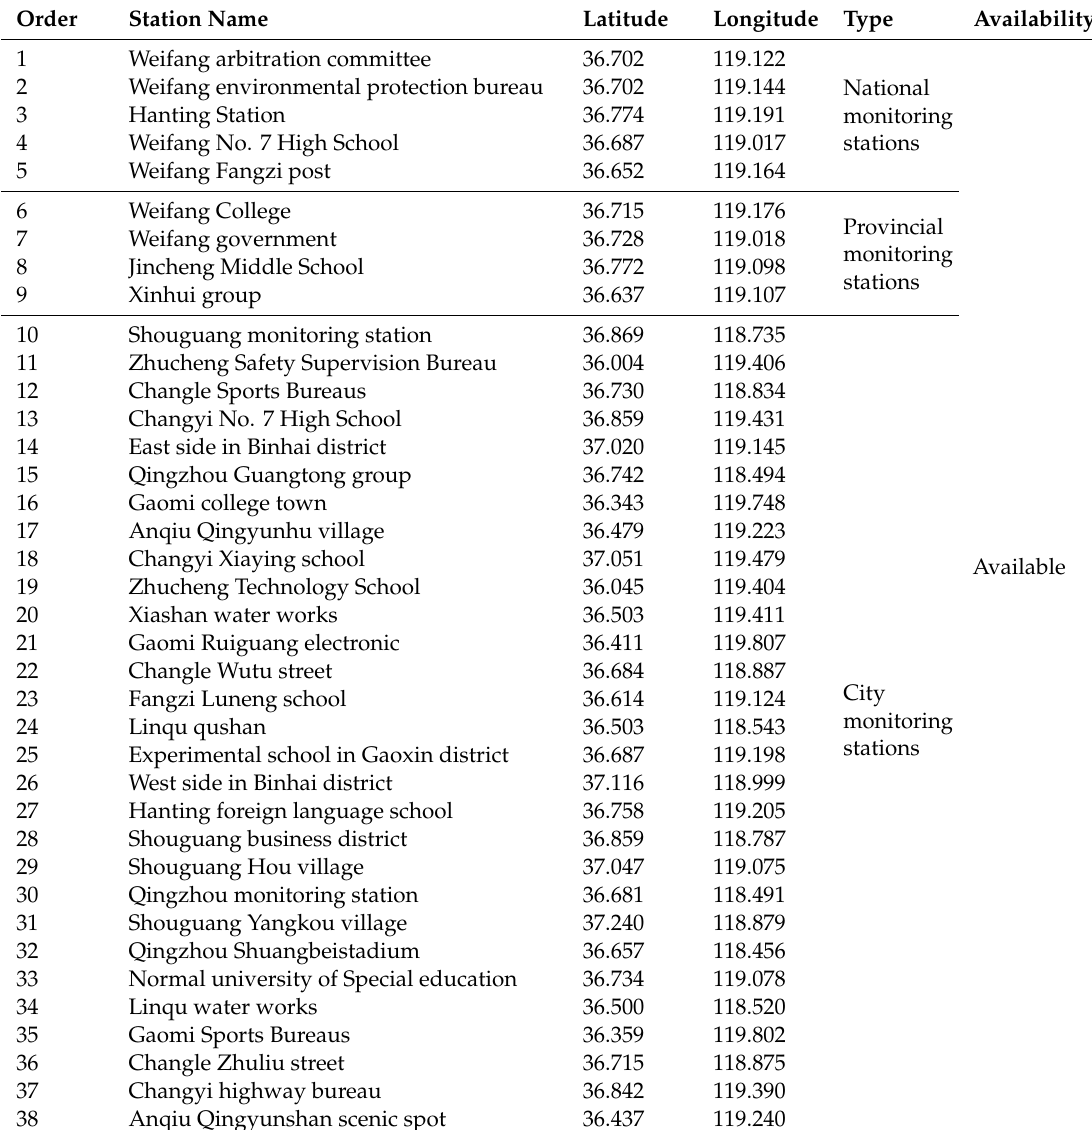
Table A1. Information of Air Monitoring